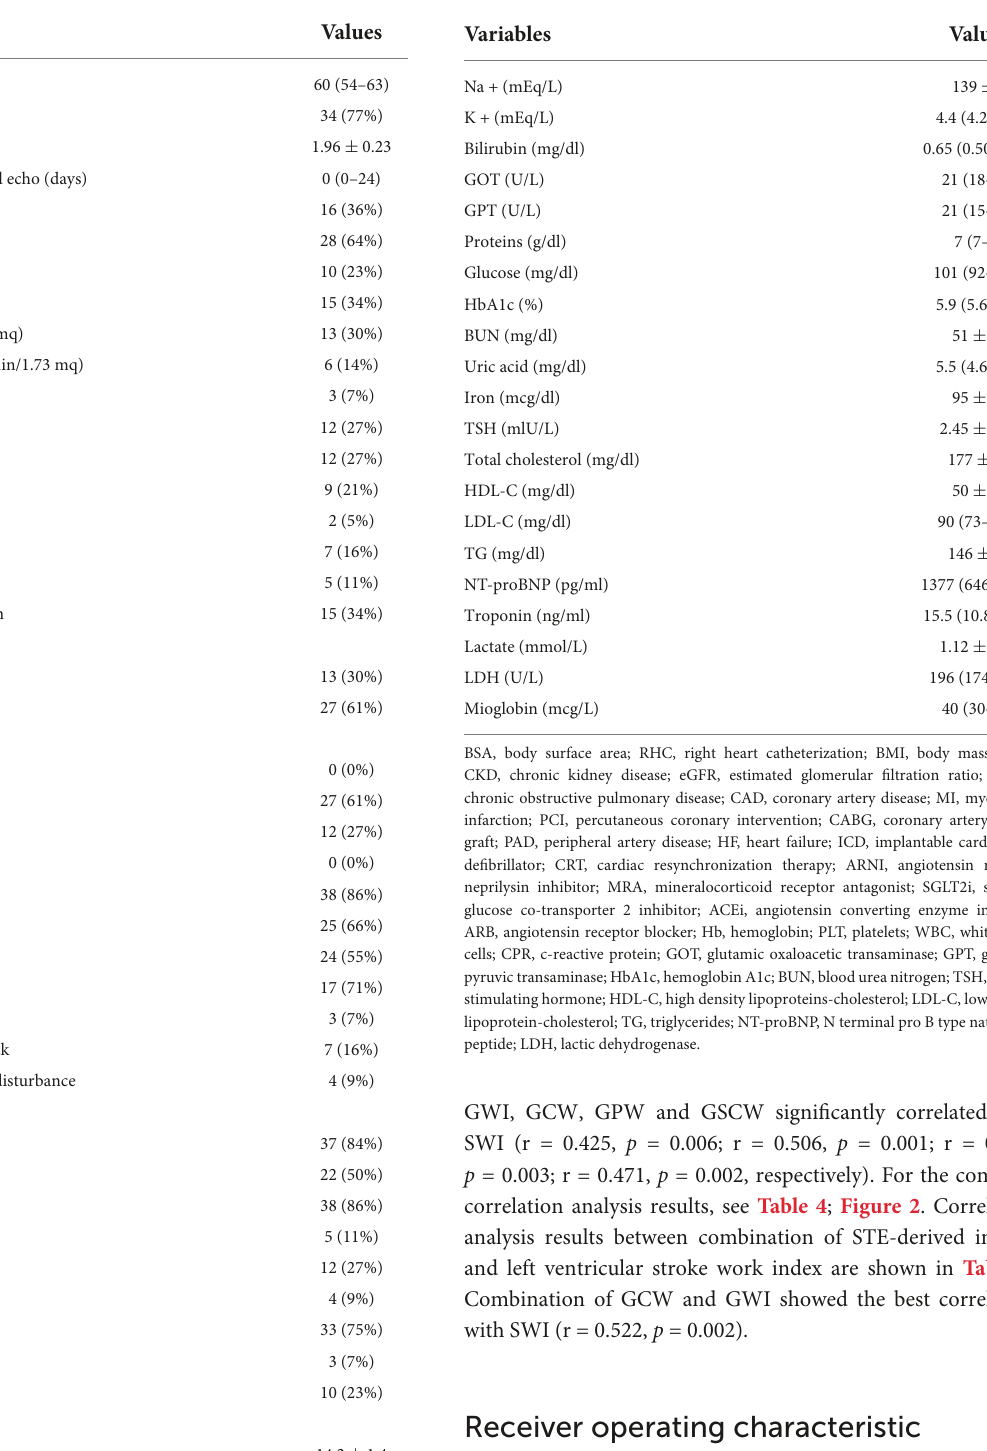
correlation analysis results, see Table 4 ; Figure 2 . Correlation analysis results between combination of STE-derived indices and left ventricular stroke work index are shown in Table 5